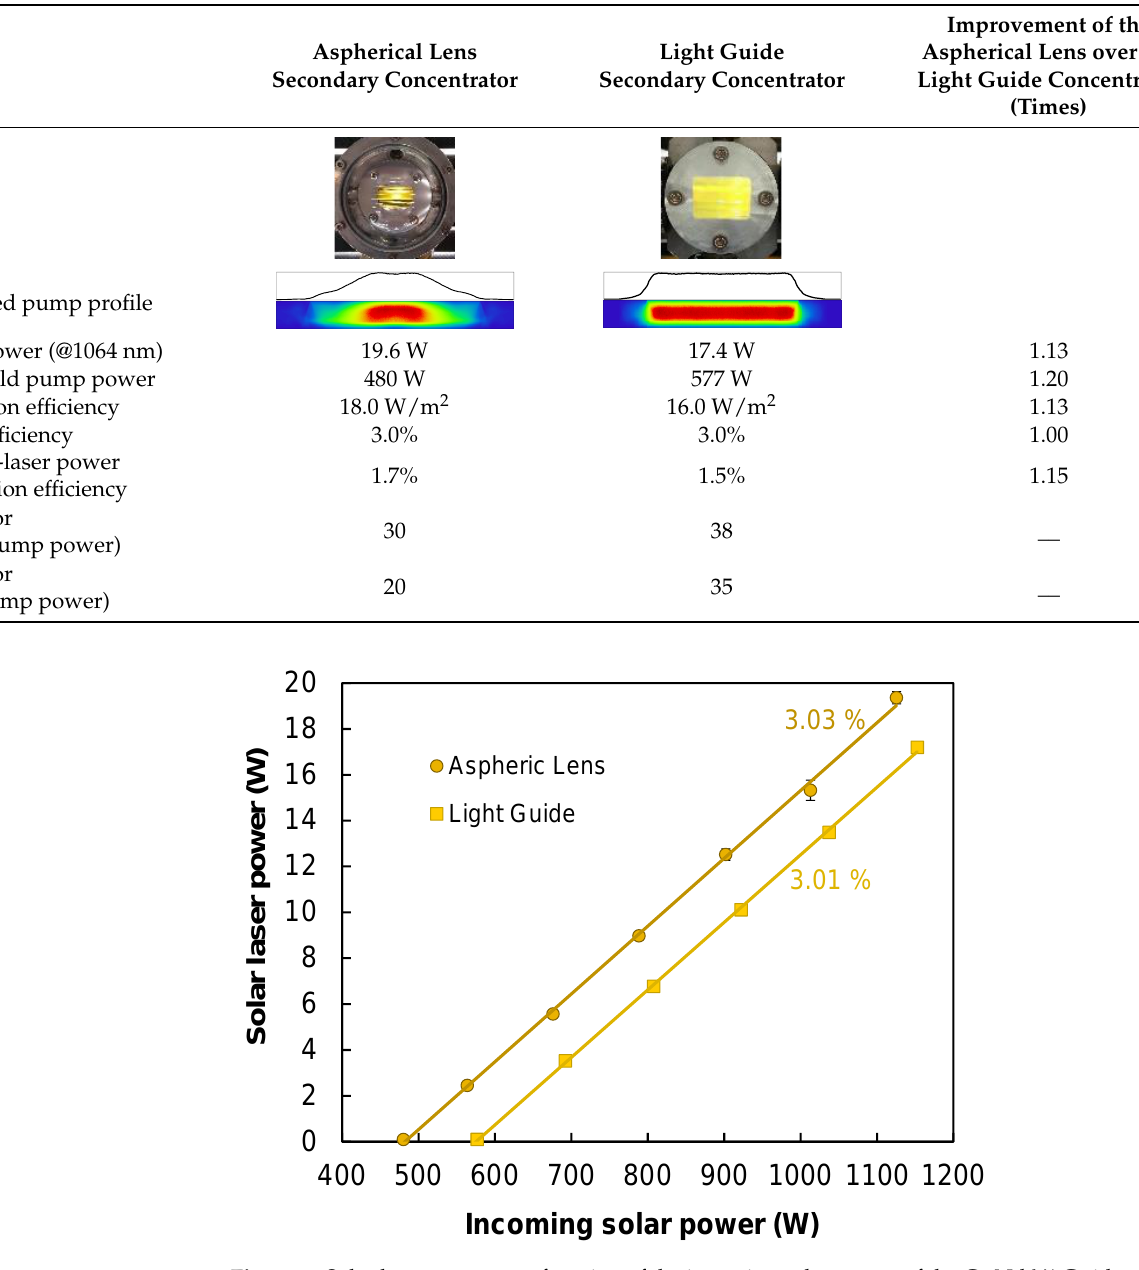
Figure 6. Solar laser power as a function of the incoming solar power of the Ce:Nd:YAG side-pumped solar lasers with the aspherical lens and the light guide secondary concentrators. Error bars, when not hidden by symbols, are for standard deviation.